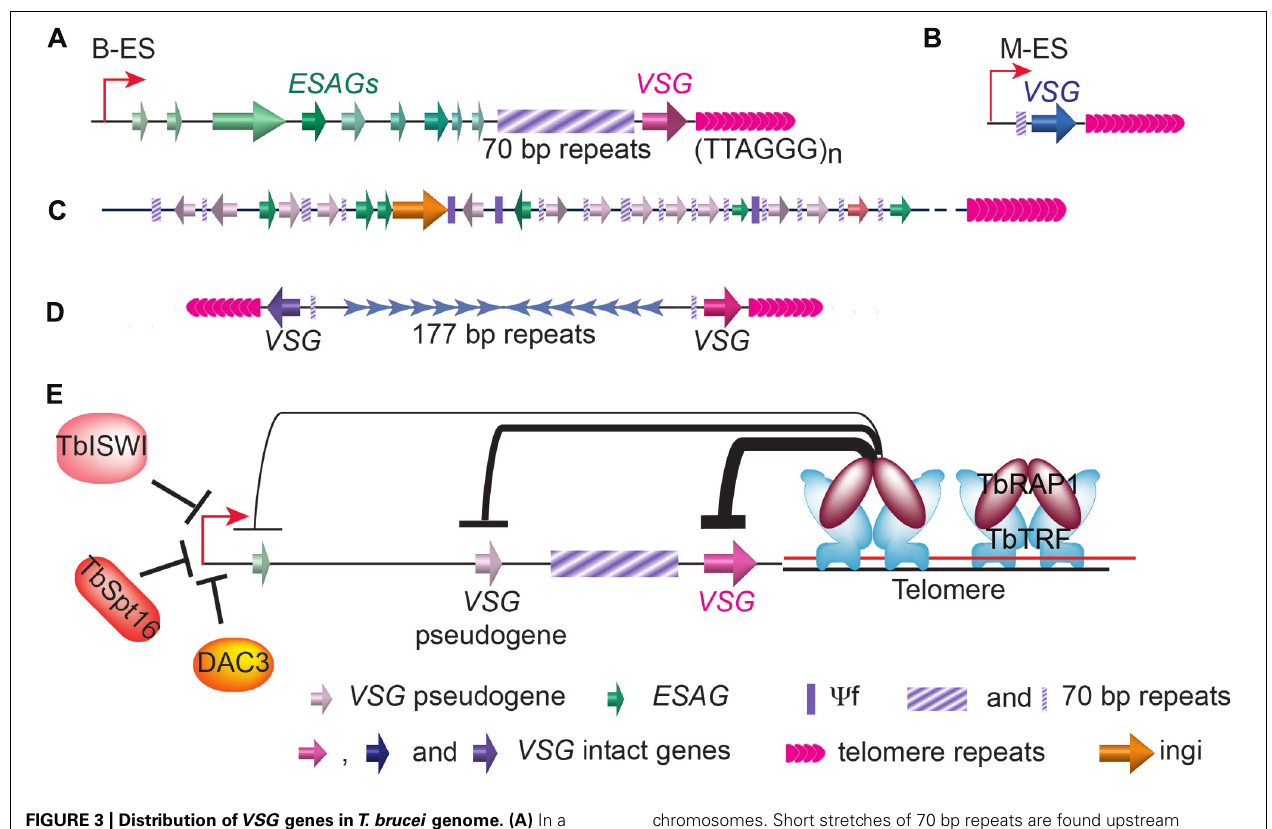
FIGURE 3 | Distribution of VSG genes in T. brucei genome. (A) In a bloodstream form VSG expression site (B-ES), the VSG gene is the last one in the large polycistronic transcription unit and is located within 2 kb of the telomere repeats. A stretch of 70 bp repeats with various length is located upstream of the VSG gene followed by a number of ES associated genes ( ESAGs ). (B) The metacyclic VSG expression site (M-ES) is a monocistronic transcription unit also located at subtelomeric region. (C) Most VSG genes and pseudogenes (and some ESAG genes) are found in gene arrays located at subtelomeric regions on megabase